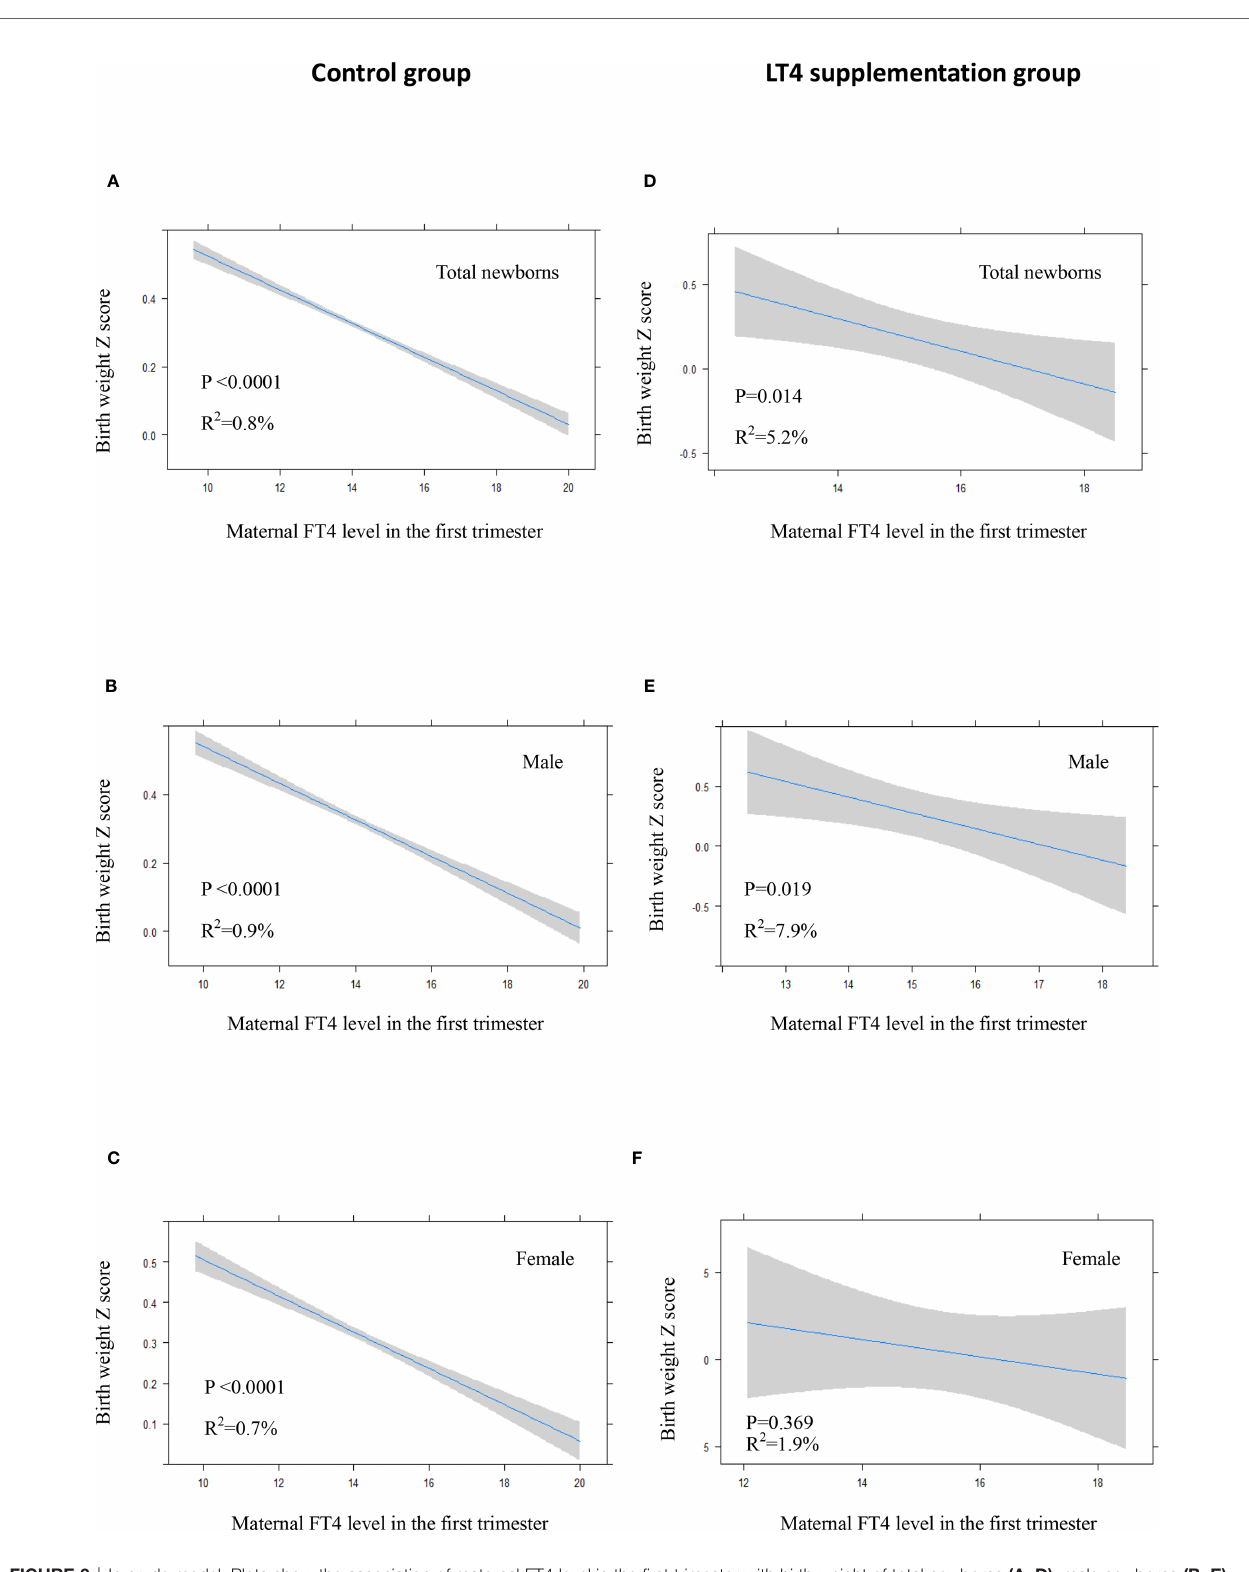
FIGURE 3 | In crude model: Plots show the association of maternal FT4 level in the fi rst trimester with birth weight of total newborns (A, D) , male newborns (B, E) and female newborns (C, F) in control group (A – C) and LT4 supplementation group (D – F) as predicted mean (blue line) with 95% con fi dence interval (CI, gray area). The neonatal birth weight was standardized for Z